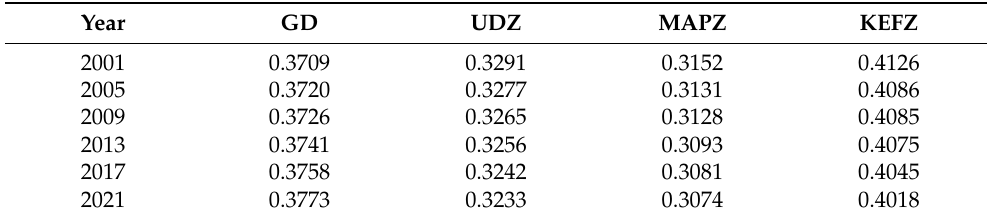
Table 4. Changes in the oblateness of carbon emissions standard deviations in Guangdong Province and its MFOZs from 2001 to